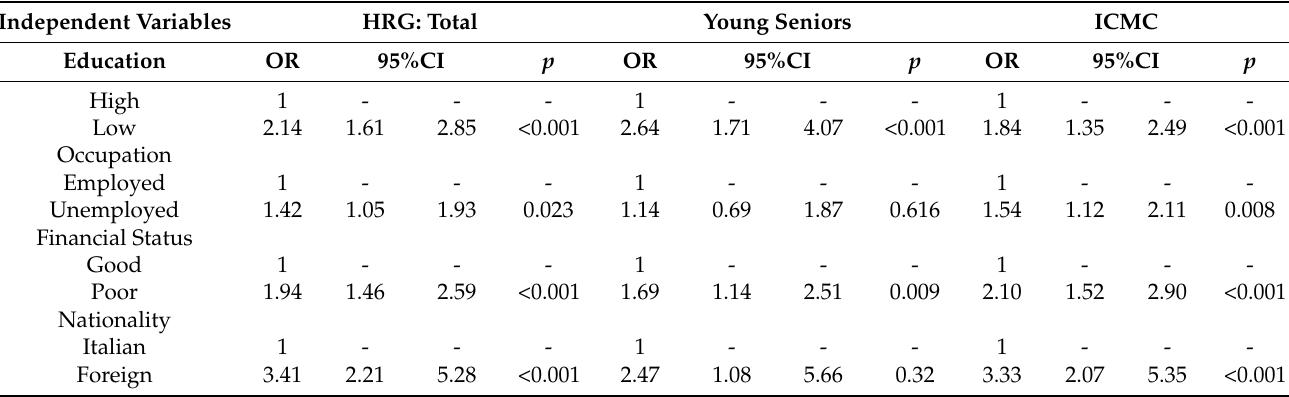
Table 2. Mediator Models: association (logistic regression analysis adjusted for age, sex and SES factors) between Health Literacy (dependent variable: inadequate Vs sufficient/problematic) and SES factors (education, occupation, financial status, nationality; independent variables) in high-risk groups (total sample, young seniors, and individuals with chronic medical conditions). HRG: high risk group; ICMC: individuals with chronic medical conditions; OR: Odds Ratio; CI: Confidence Interval. SES: socioeconomic